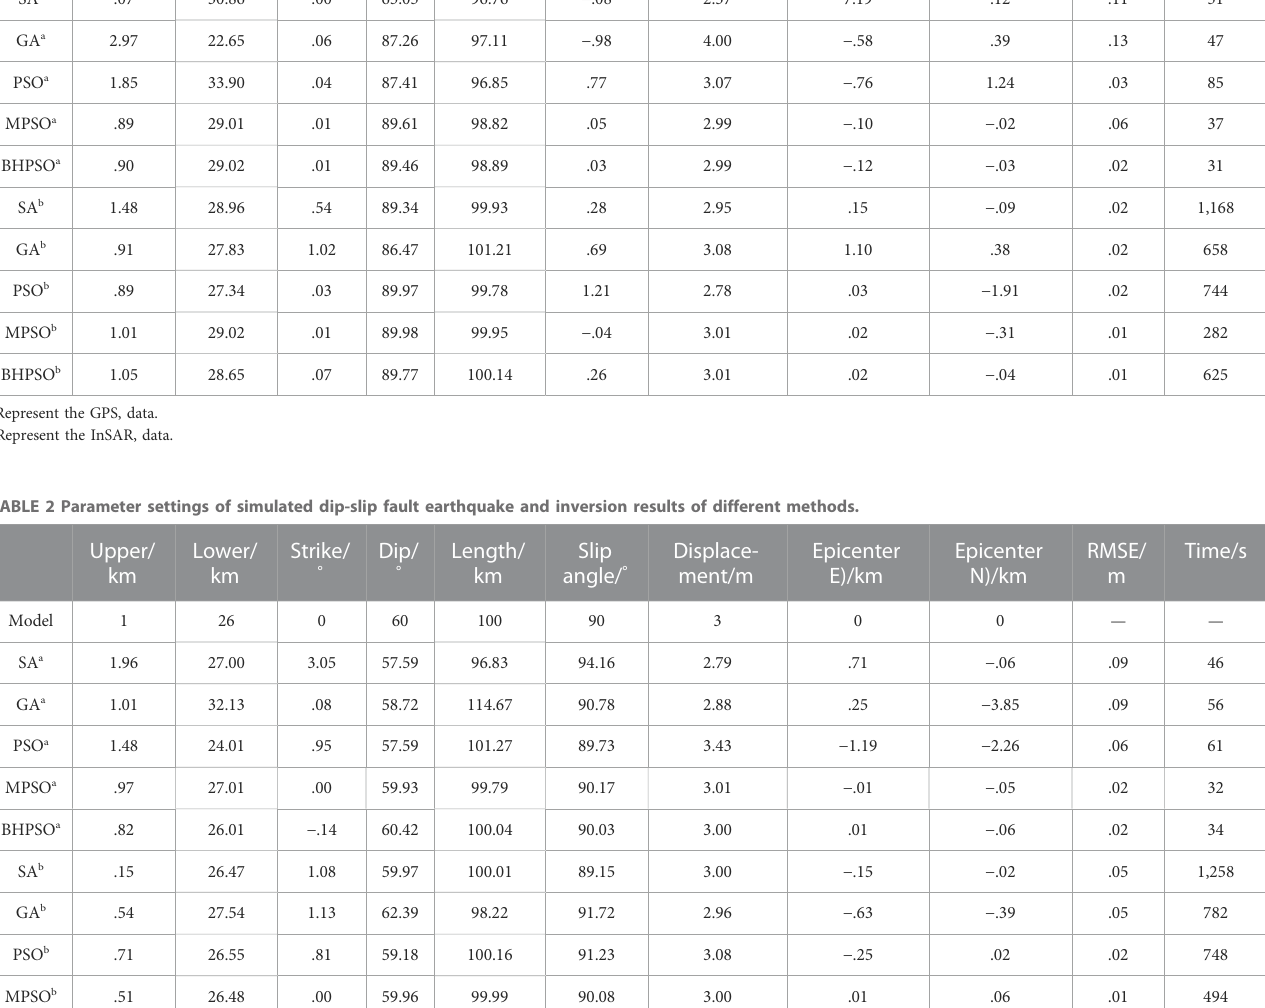
TABLE 1 Parameter settings of simulated strike-slip fault earthquake and inversion results of different methods. Upper/ km